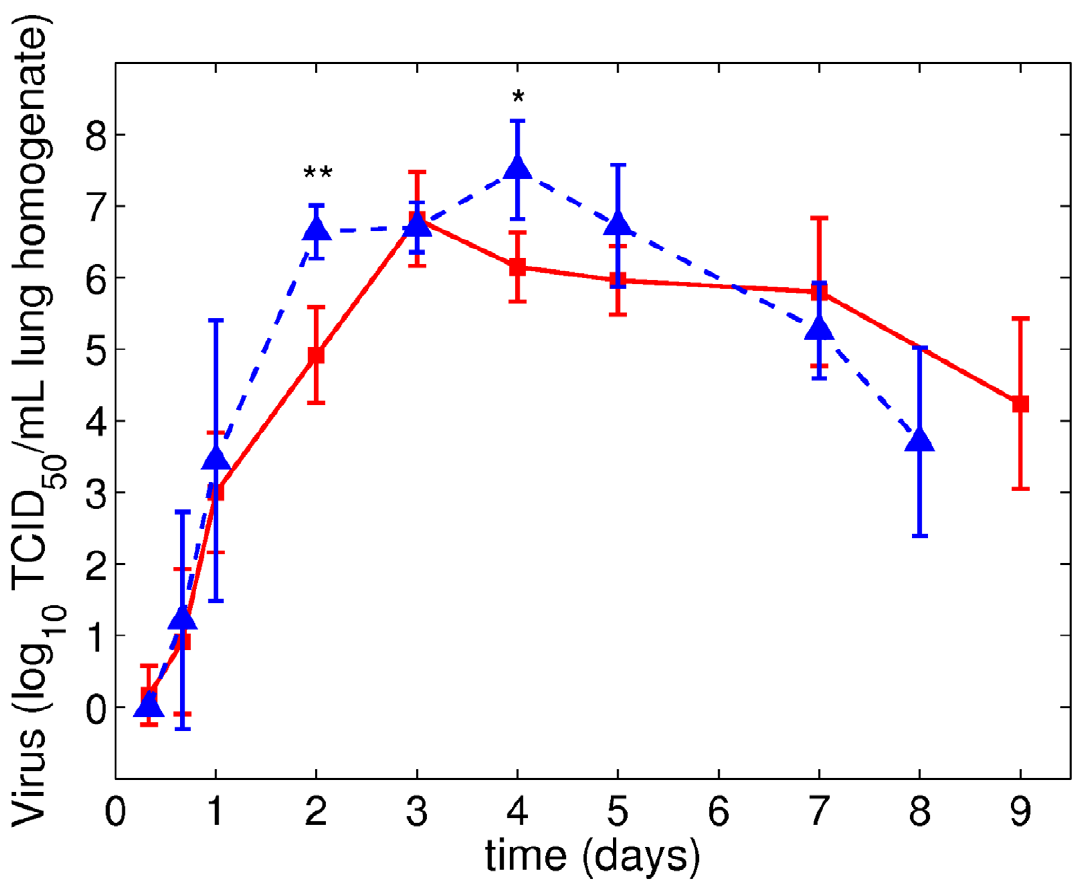
Figure 1. Log 10 values of viral titers per ml of lung homogenate from groups of 6–10 mice infected intranasally with 100 TCID 50 of influenza A virus PR8 (squares) or PR8-PB1-F2(1918) (triangles). Data are given as geometric means + SD. T-tests were used to determine significance of differences of viral titers between these two strains for each time point, (cid:2)(cid:2) p v 0 : 001 , (cid:2) p v 0 : 01 .